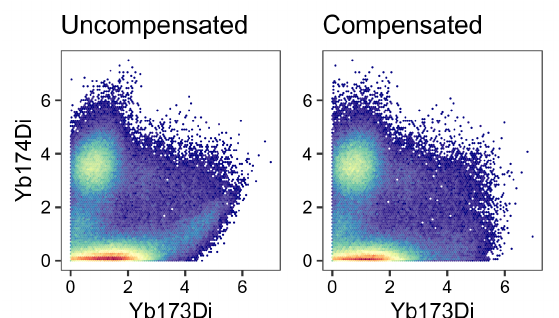
Figure 9. Scatter plots for two exemplary channels before (left) and after correction for spillover